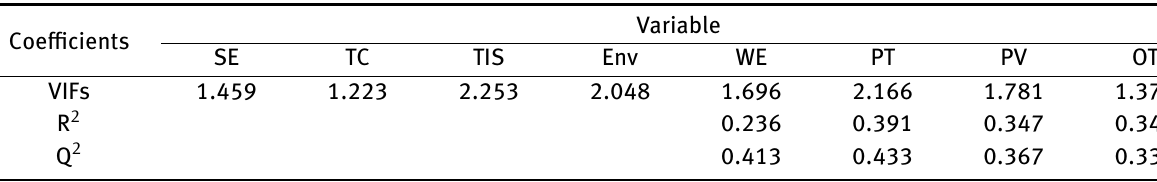
Table 7: Latent variable coeflcients for evaluation of structural models